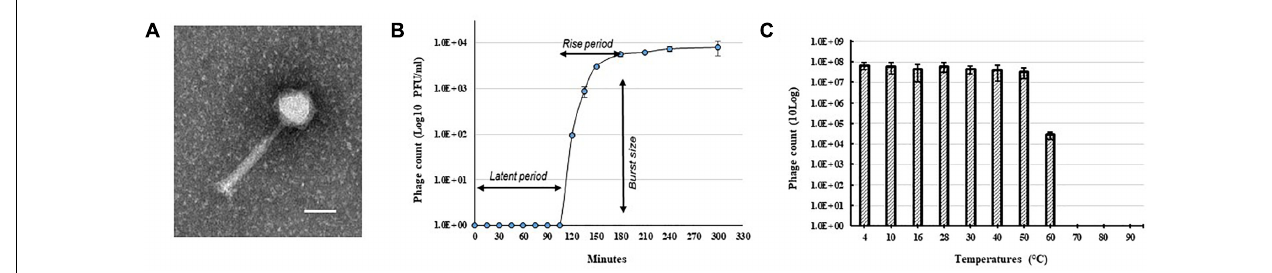
FIGURE 1 | Morphology and growth characteristics of Ralstonia phage RsoM1USA. (A) Transmission electron micrograph of the purified phage virion. The scale represents 50 nm. (B) One-step growth curve of the phage with R. solanacearum strain RUN302 as the host. The phage was added at a MOI of 0.01 and allowed to adsorb for 15 min at 28 ◦ C. Phage titers were determined every 30 min using the plaque assay. The latent period is when no release of phage particles was observed. The rise period begins with the end of the latent period and ends when the increase in phage titers ceases. The burst size is the average number of phage particles released per infected cell. (C) Effect of temperature on the stability of phage RsoM1USA. 10 8 PFU of phage RsoM1USA was incubated at each temperature point and the number of phage was estimated by plaque assay using R. solanacearum RUN302 as a host 1 h after incubation. Means are based on three separate experiments, each containing three replicates. Bars indicate standard errors.